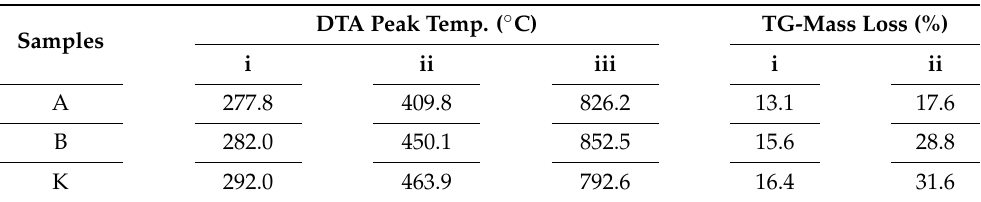
Figure 2. DTA-TG curves related to the samples A, B, and K at a heating rate of 20 ◦ C/min. Table 2. The DTA peak temperatures and mass loss occurred in every stage, extracted from DTA-TG curves (presented in Figure